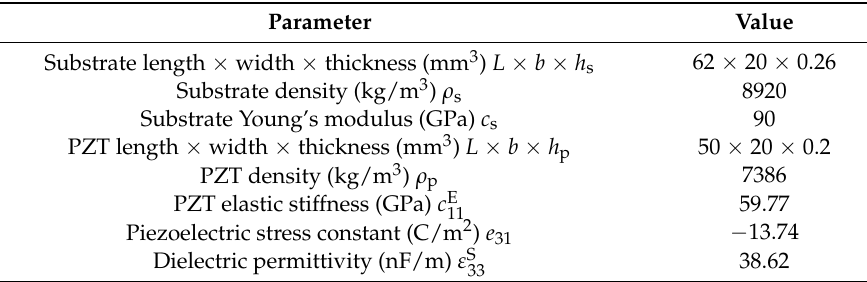
Figure 2. Prototype of the hybrid energy harvester (HEH). Table 1. Geometric and material parameters of the HEH.